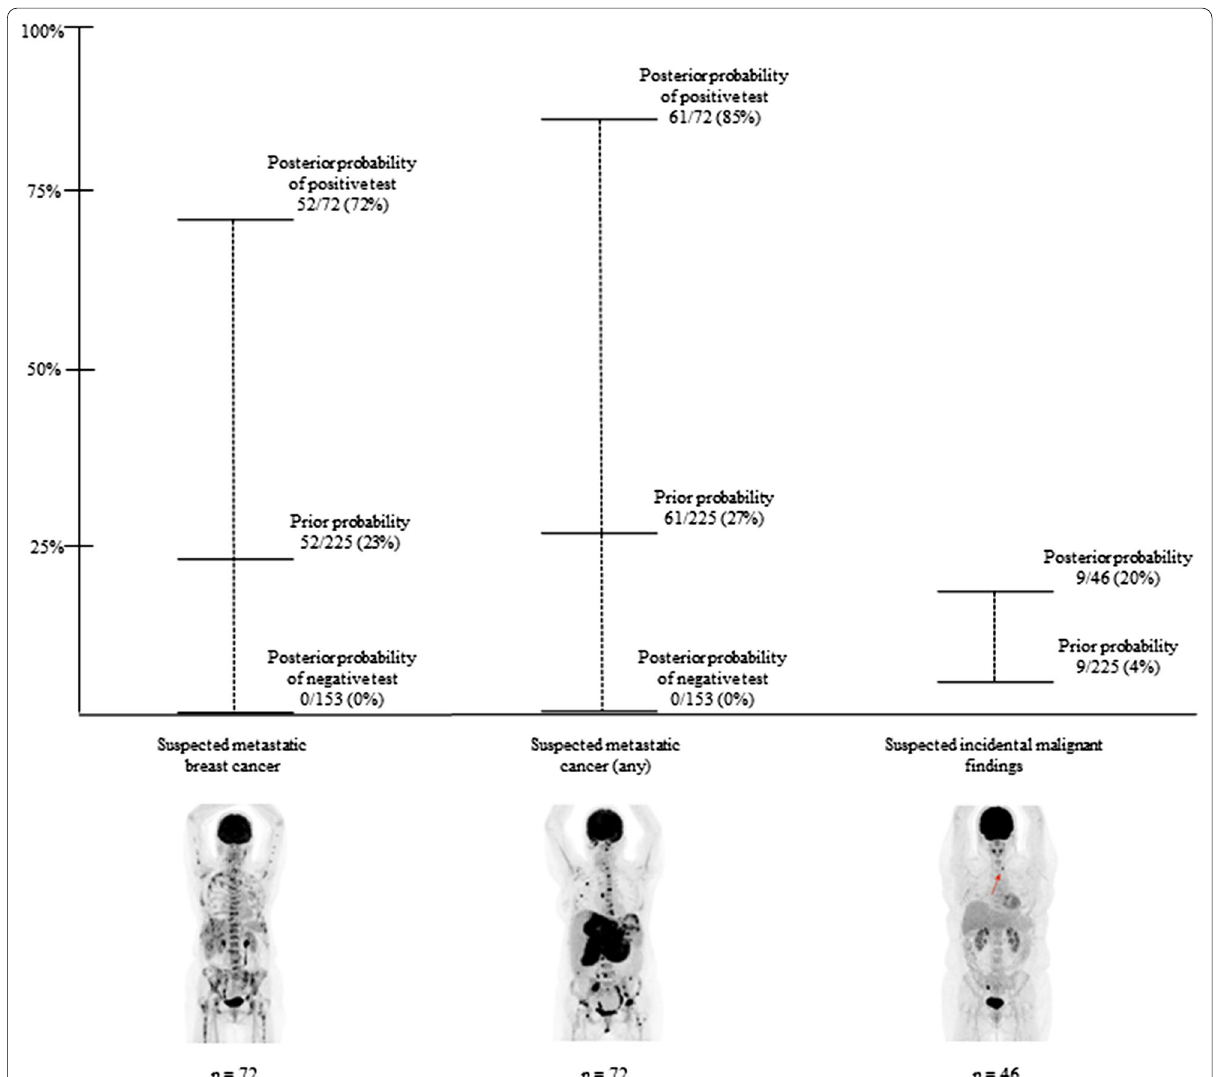
Fig. 2 Prior and posterior probabilities for metastatic breast cancer, any metastatic cancer, and incidental malignancies according to [ 18 F]FDG‑PET/